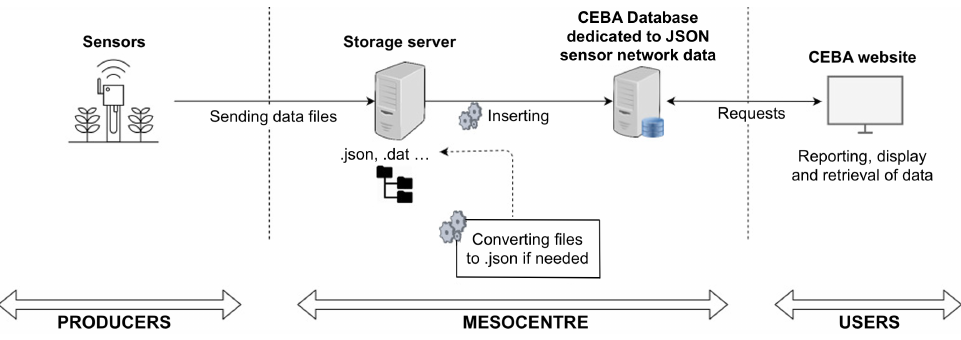
Figure 5. Dataflow for sensors database